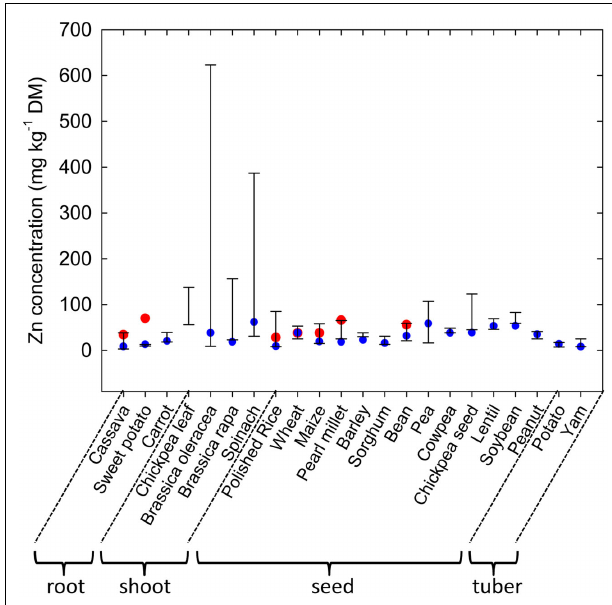
FIGURE 2 |Variation in zinc (Zn) concentrations in roots, shoots, seeds and tubers of edible crops. Bars represent maximum and minimum values obtained for large collections of cassava (Chávez et al., 2005), sweet potato (Pfeiffer and McClafferty, 2007), carrot (Nicolle et al., 2004), chickpea (leaves; Ibrikci et al., 2003), Brassica oleracea (Broadley et al., 2010), Brassica rapa (Wu et al., 2007), spinach (Grusak and Cakmak, 2005), rice (Yang et al., 1998), wheat (Graham et al., 1999), maize (Bänziger and Long, 2000), pearl millet (Velu et al., 2007), barley (P. J.White and I. J. Bingham cited inWhite and Broadley, 2009), sorghum (Reddy et al., 2005), bean (Islam et al., 2002), pea (Grusak and Cakmak, 2005), cowpea (Pfeiffer and McClafferty, 2007), chickpea (seed, M. A. Grusak cited inWhite and Broadley, 2009), lentil (Pfeiffer and McClafferty, 2007), soybean (Raboy et al., 1984), peanut (Branch and Gaines, 1983), potatoes (White et al., 2009), and yam (Agbor-Egbe andTrèche, 1995) genotypes. Blue circles indicate Zn concentrations in the U.S. Department of Agriculture, Agricultural Research Service (2011). Red circles indicate target Zn concentrations proposed by the HarvestPlus program (Bouis andWelch,